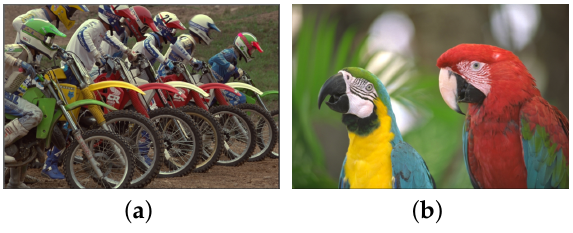
Figure 3. 4 × 4 enlargement results of our image interpolation. ( a ) 4 × 4 enlargement result of Kodim05; ( b ) 4 × 4 enlargement result of